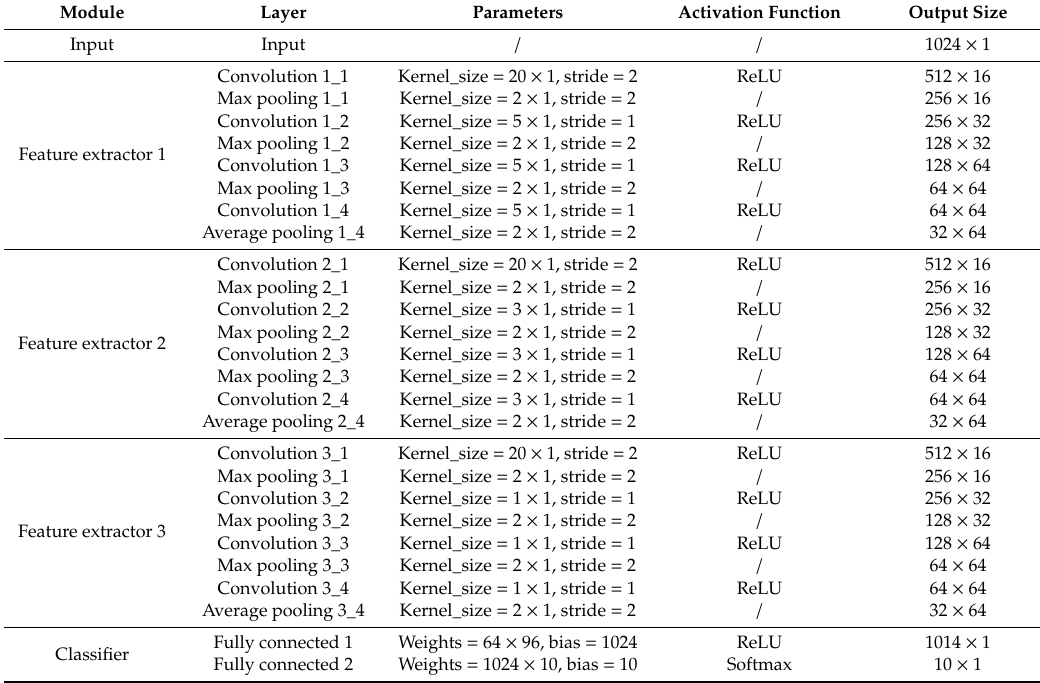
Table 1. Details of 1D multi-scale Convolutional Neural Network